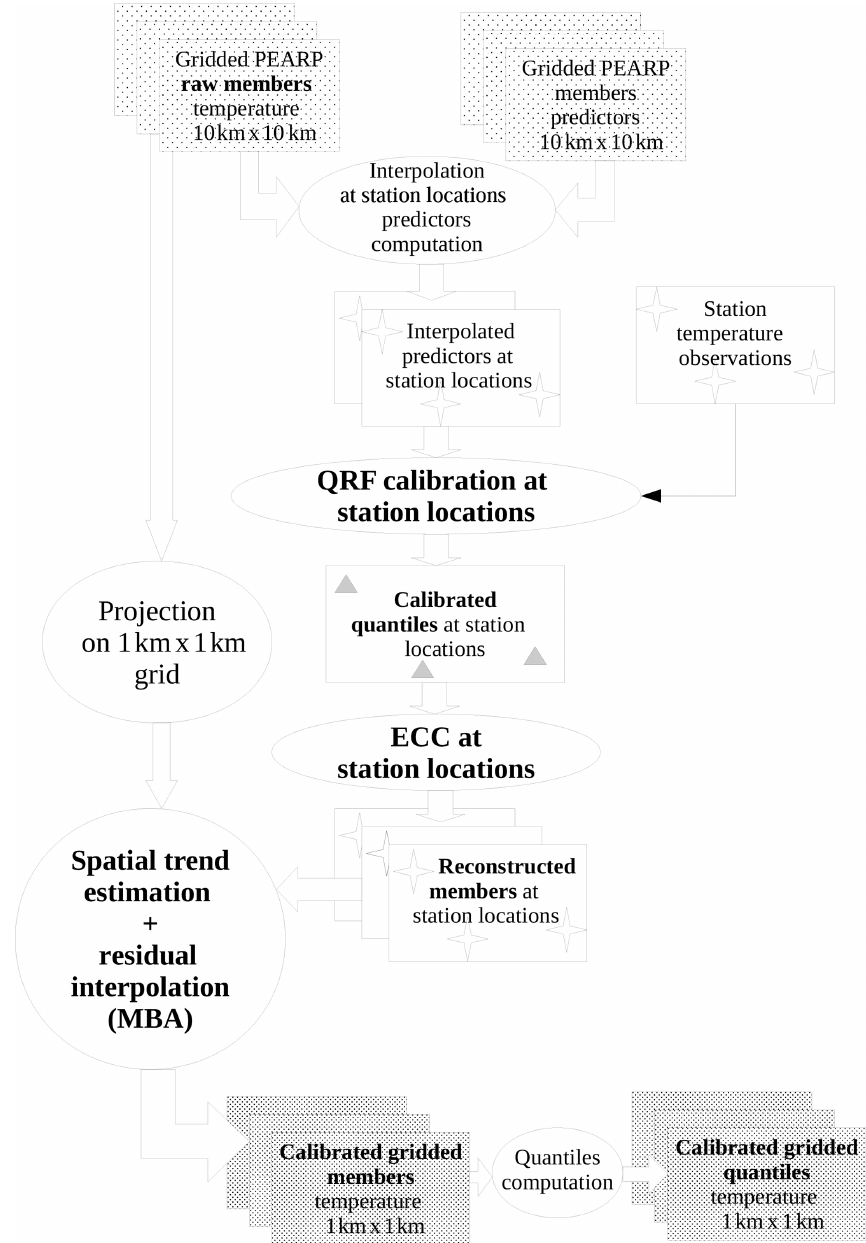
Figure 1. Flowchart of the temperature post-processing